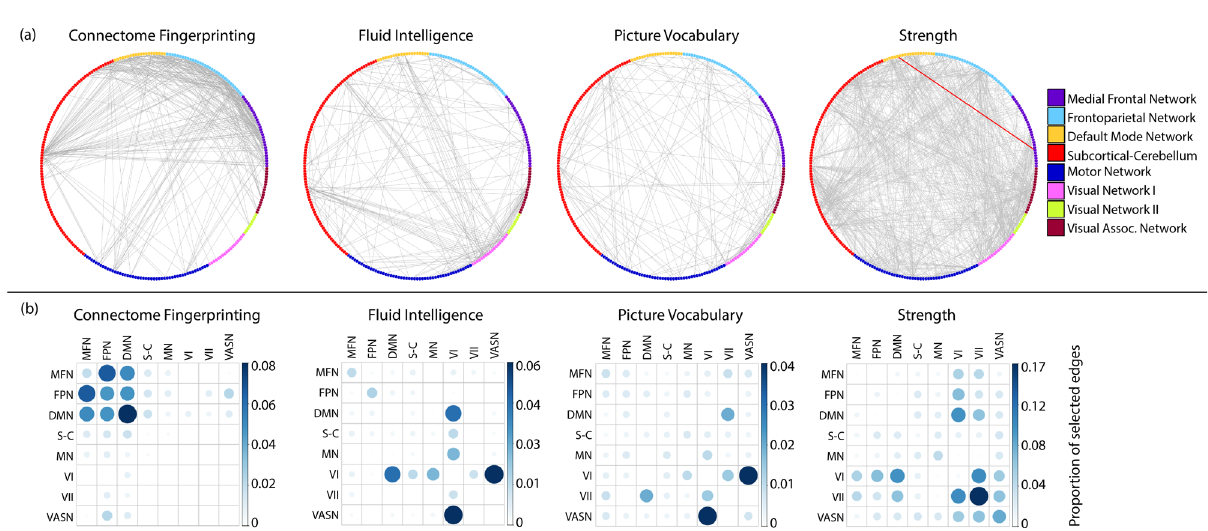
Fig. 2 Single-edge and between-network overlap for fi ngerprinting and prediction. a Grey lines mark highly discriminatory edges for fi ngerprints and predictive edges for behaviour, thresholded at the 99th percentile or p < 0.01 respectively. Red lines, only available for strength, visualise overlap. For fl uid intelligence and language comprehension, no edges overlapped. b Shows the entire network-by-network matrix of the same selected edges, adjusted for a total number of